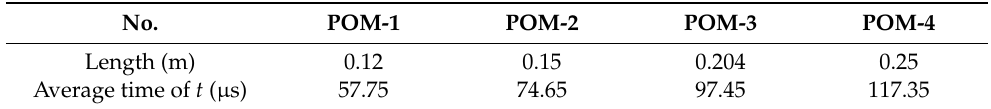
Table 1. Testing time for P-wave of POM rods.